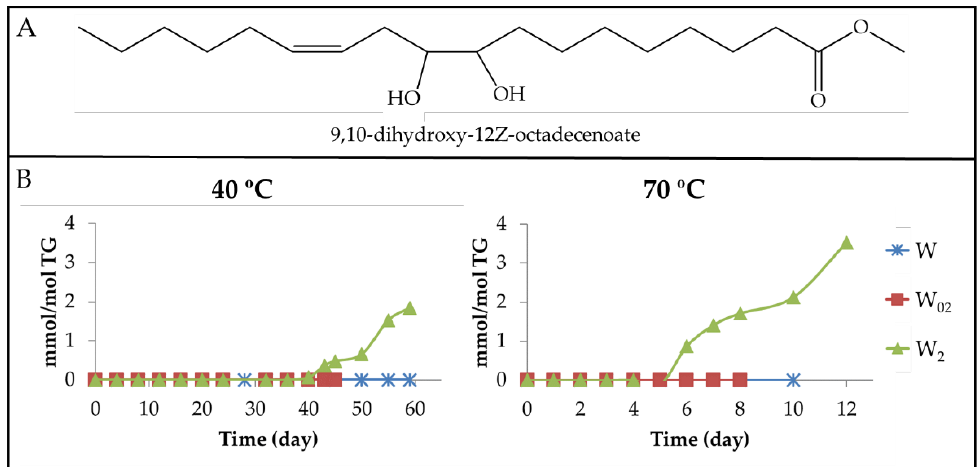
Figure 19. ( A ) Structure of 9,10-dihydroxy-12 Z -octadecenoate as an example of a long-chain deriv- ative supporting a vicinal dHO group. ( B ) Evolution of the concentration expressed as mmol/mol TG, of vicinal dHO supported in long chains in walnut oil with different enrichment levels of α T (W, W 02 and W 2 ) submitted to either 40 ◦ C or 70 ◦ C, up to advanced stages of the oxidation